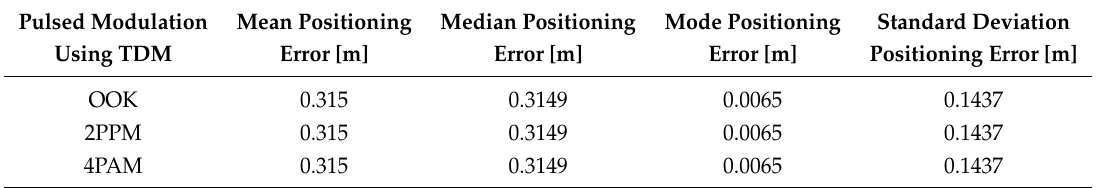
Table 3. Coarse Phase Positioning Performance for Pulsed Modulations using Time Division Multiplexing.